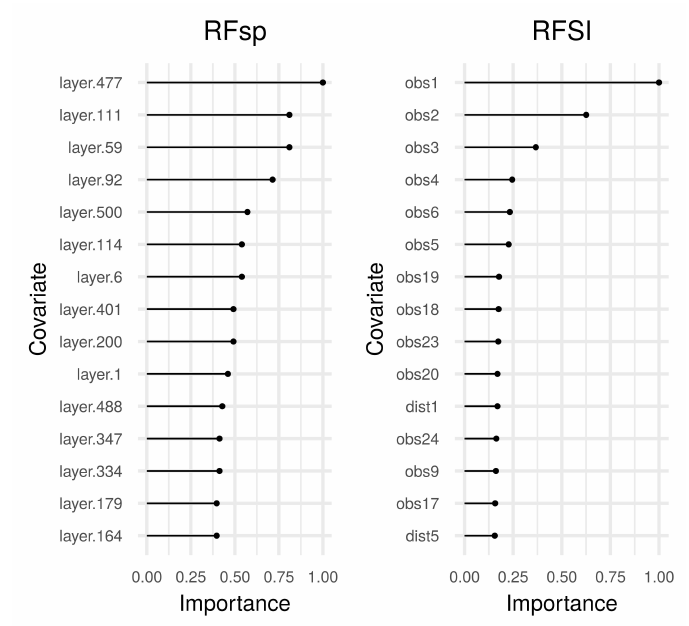
Figure 6. Covariate importance plot for RFsp ( left ) and RFSI ( right ), for the case shown in Figure 5. The importance index is scaled to a maximum of 1, obs i and dist i represent observations and distances to the i -th nearest observation location, and layer. i represents buffer distances to the i -th observation location.